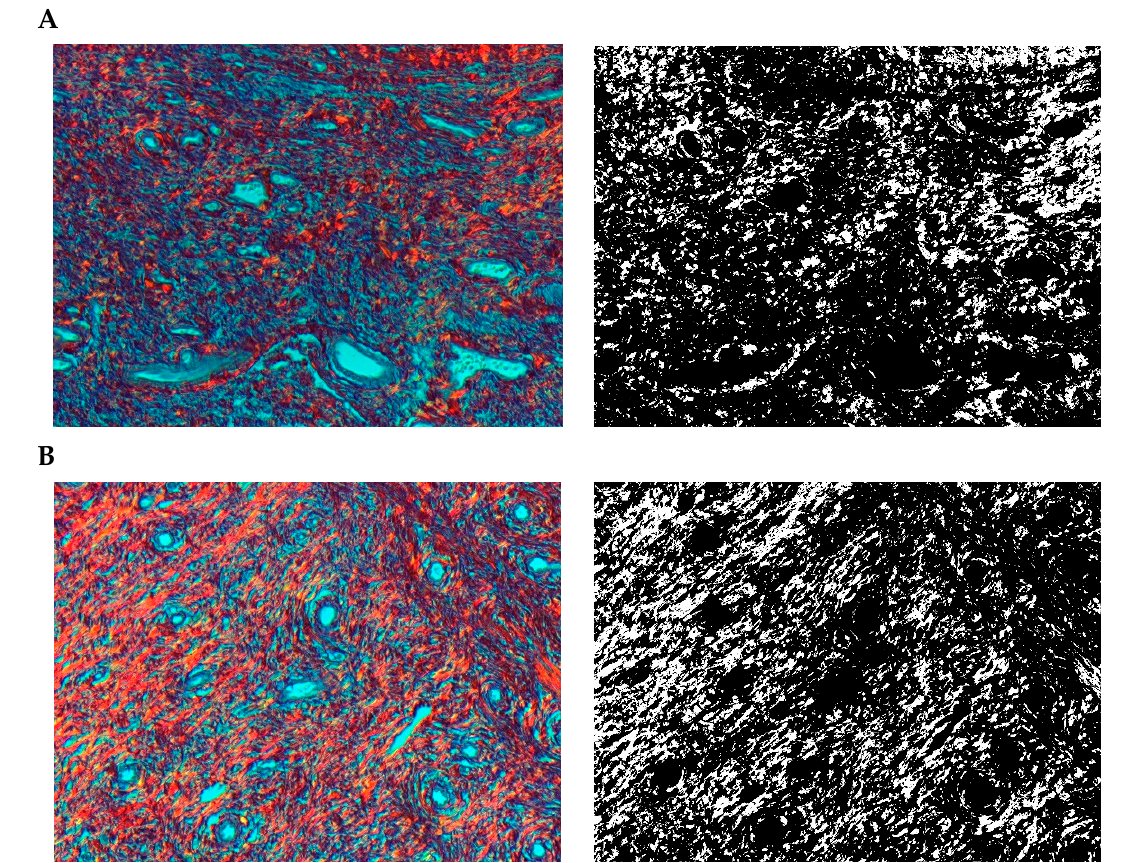
Figure 9. Segmentation before ( A ) and after ( B ) treatment (picrosirius red staining).